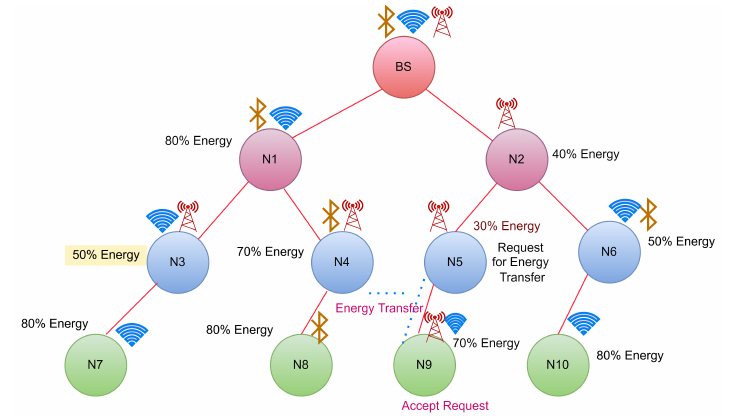
Figure 5. Case 2:Energy request from N5 to its neighbour hops.